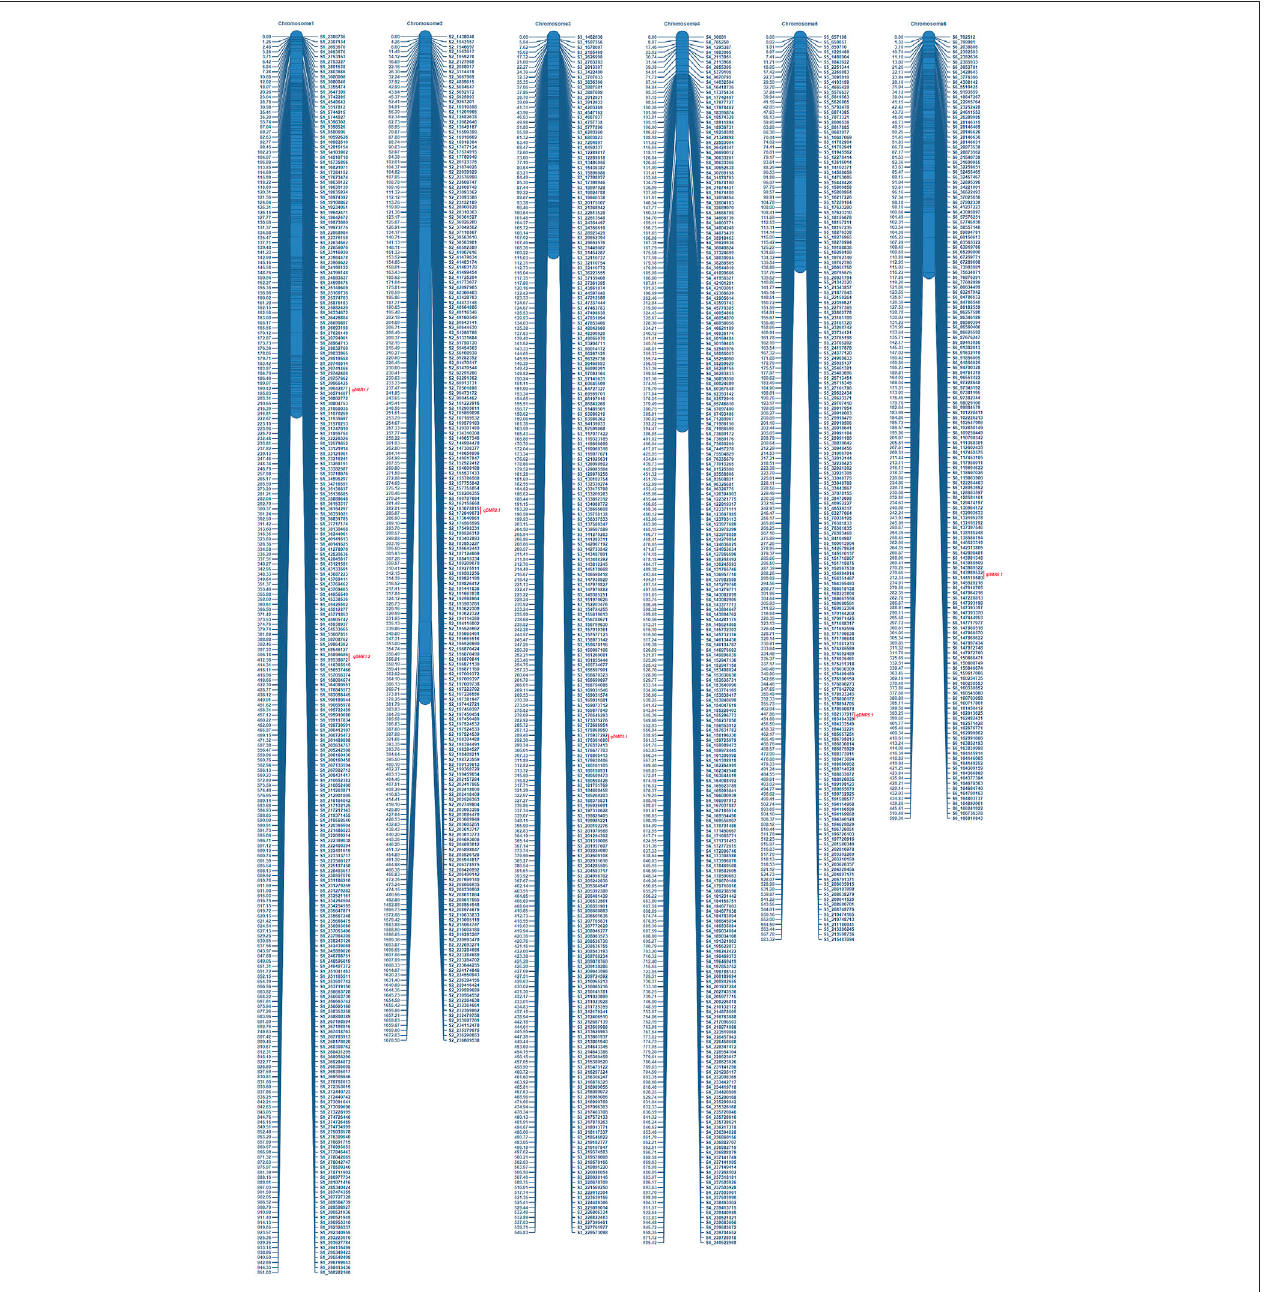
FIGURE 3 | Genetic linkage map of recombinant inbred line (RIL) population developed from the cross of UMI79×UMI936 (w) Note: For each chromosome, the SNP markers were shown on right side, and the genetic distances in cM on the left side. QTL are depicted on the right side with red color.